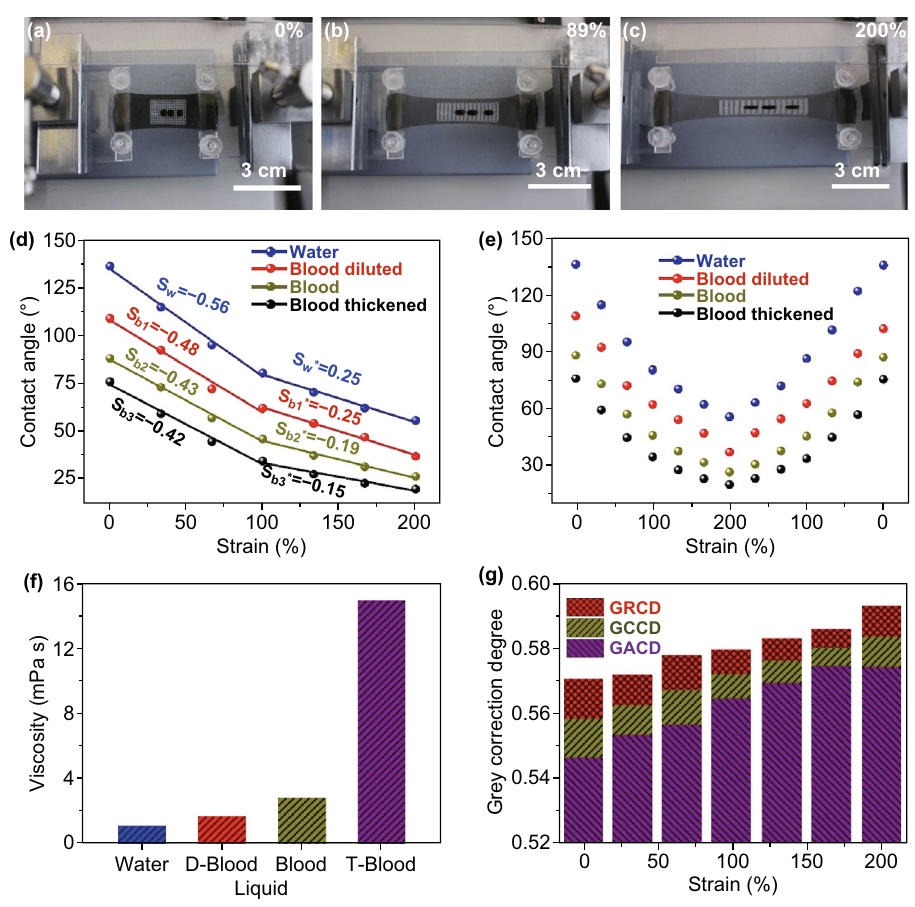
Fig. 5 a – c Photographs of the film with the stretched liquid drop of different viscosities. d Curves of contact angle–strain for different liquids. e Cycle performance of different liquids. f Viscosities of liquids used. g Grey relational degree of the film among the applied strains, the corre‑ sponding contact angles, and